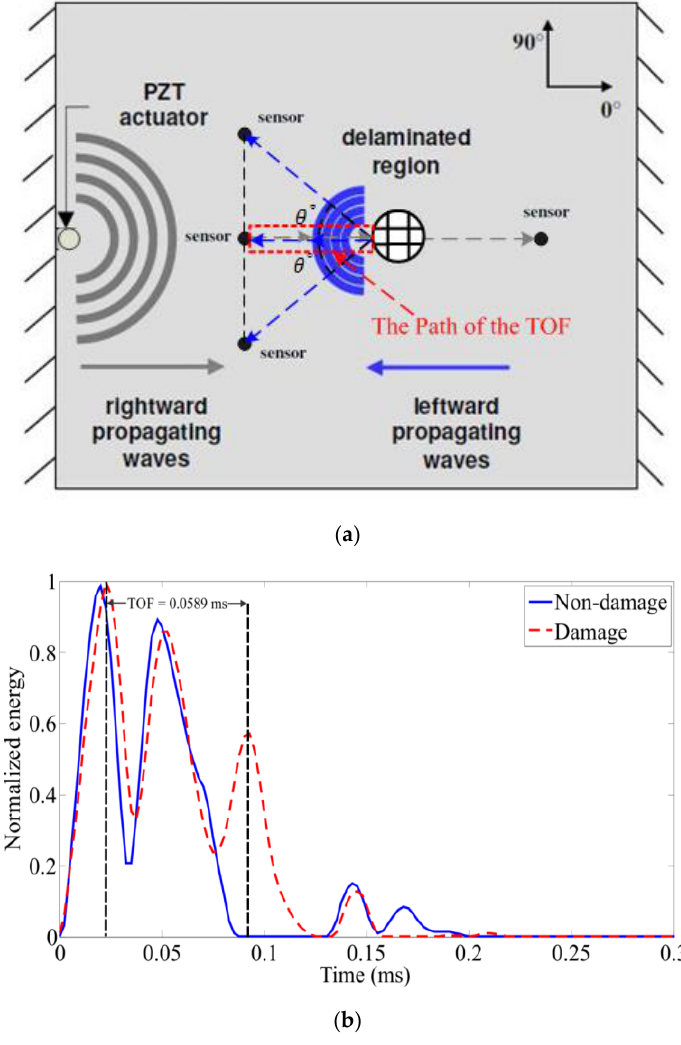
Figure 3. A demonstration of the TOF. ( a ) The wave propagating path encountering a delamination in a CFRP specimen; ( b ) Extraction of the TOF of the delamination.